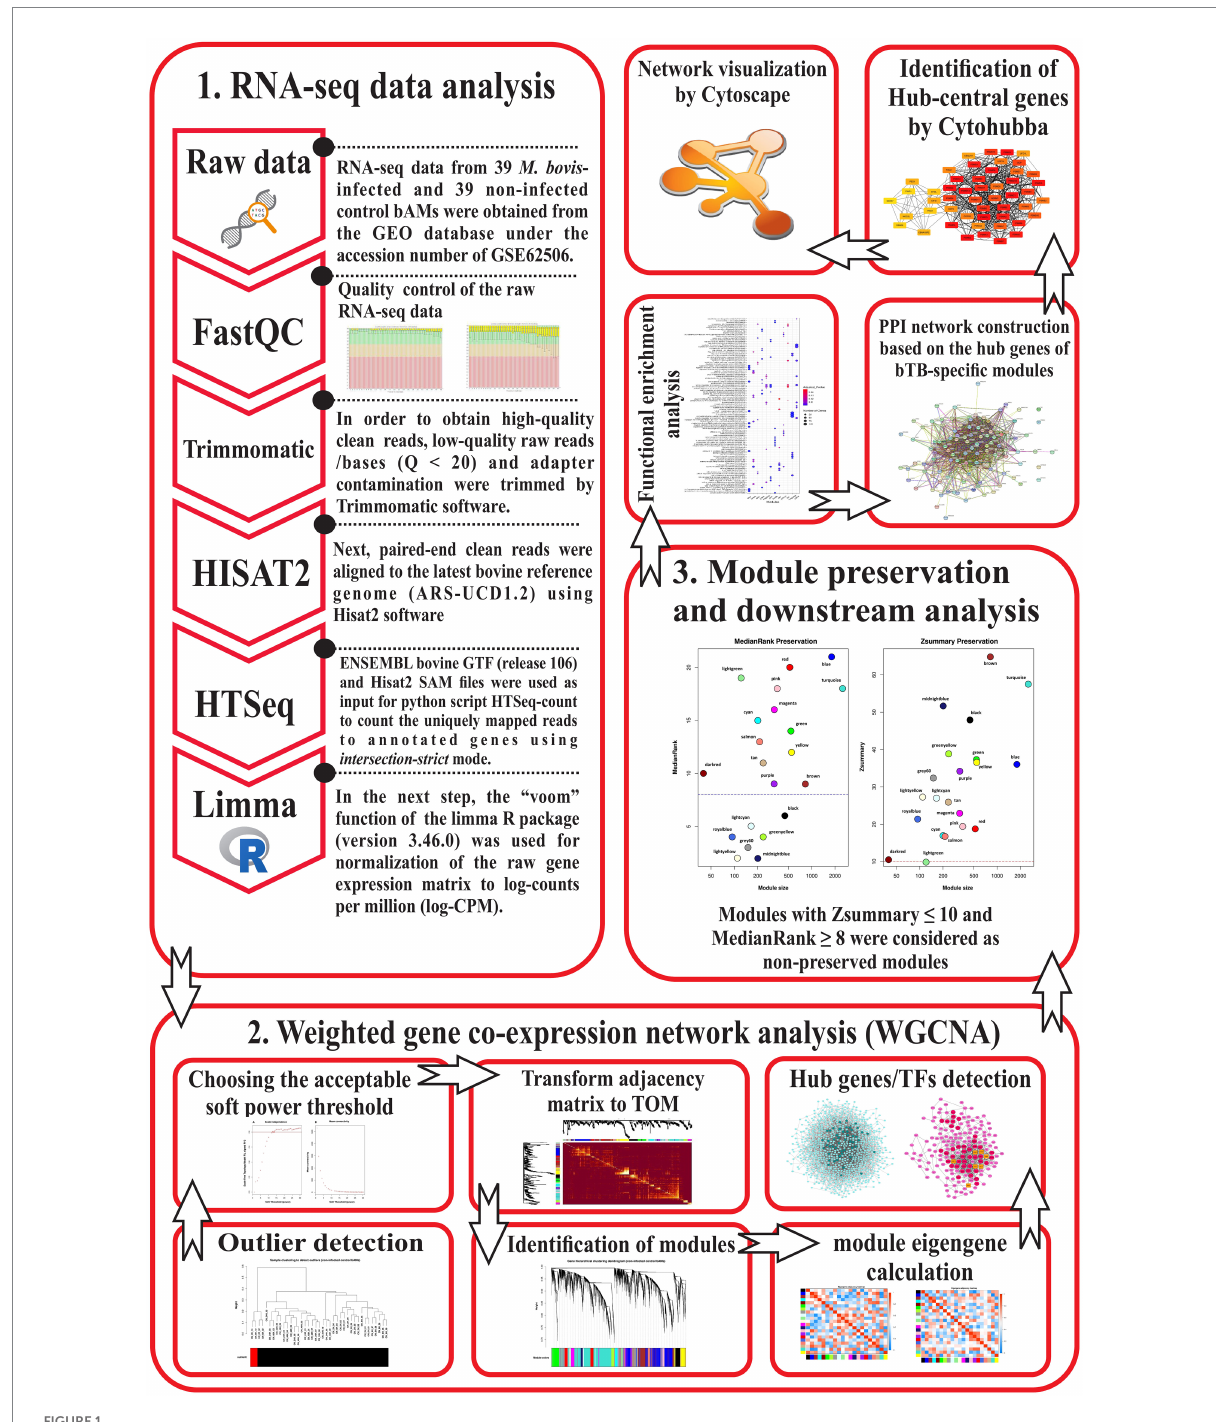
FIGURE 1 Schematic pipeline of RNA-seq data analysis and weighted gene co-expression network construction